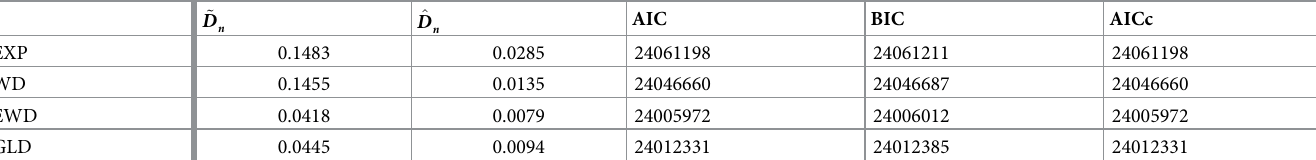
Table 3. Comparisons of fitted distributions to the 2014 firm age data.